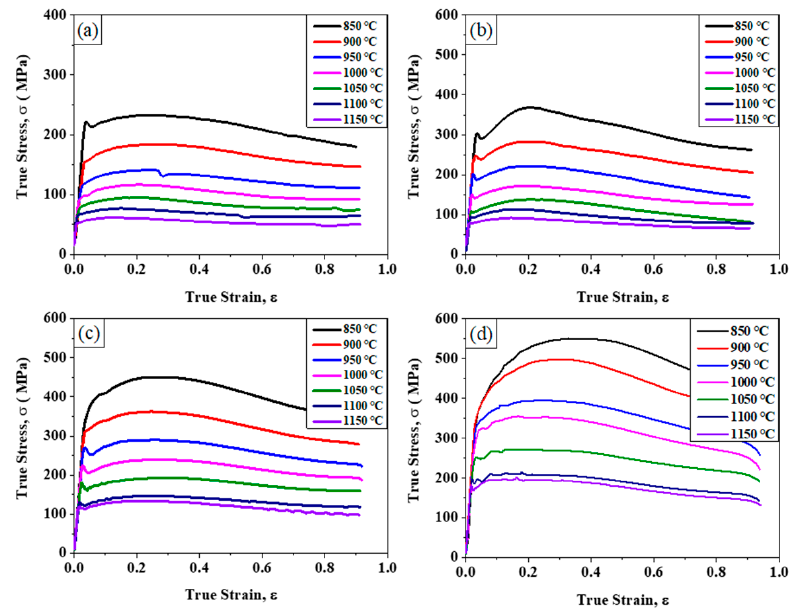
Figure 2. True stress-true strain curves of the experimental steel obtained at different deformation temperatures and under strain rates of ( a ) 0.01 s − 1 , ( b ) 0.1 s − 1 , ( c ) 1 s − 1 and ( d ) 10 s − 1 .